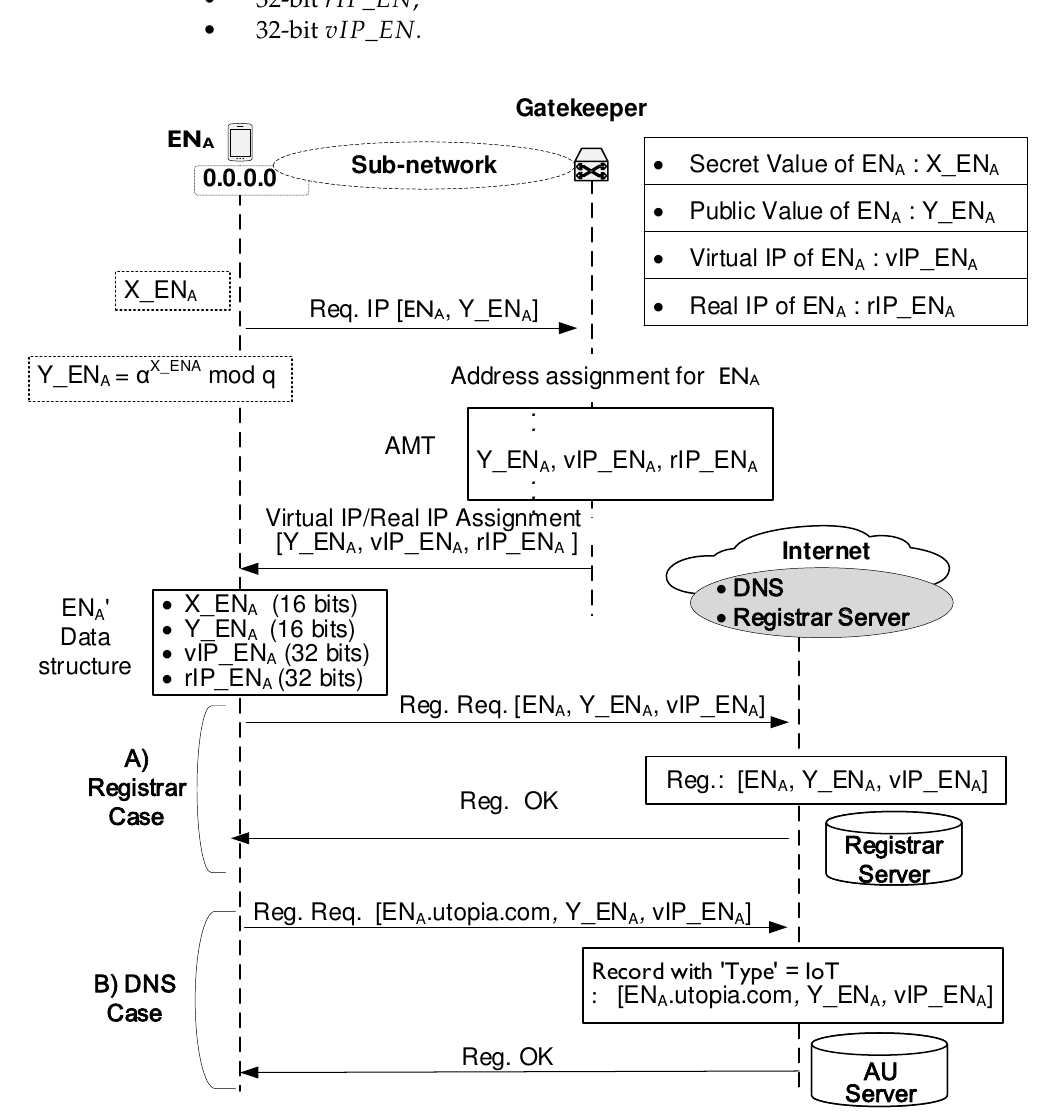
Figure 2. IoT device, gatekeeper, and Registrar Server (or DNS) sharing information about the relationship between the